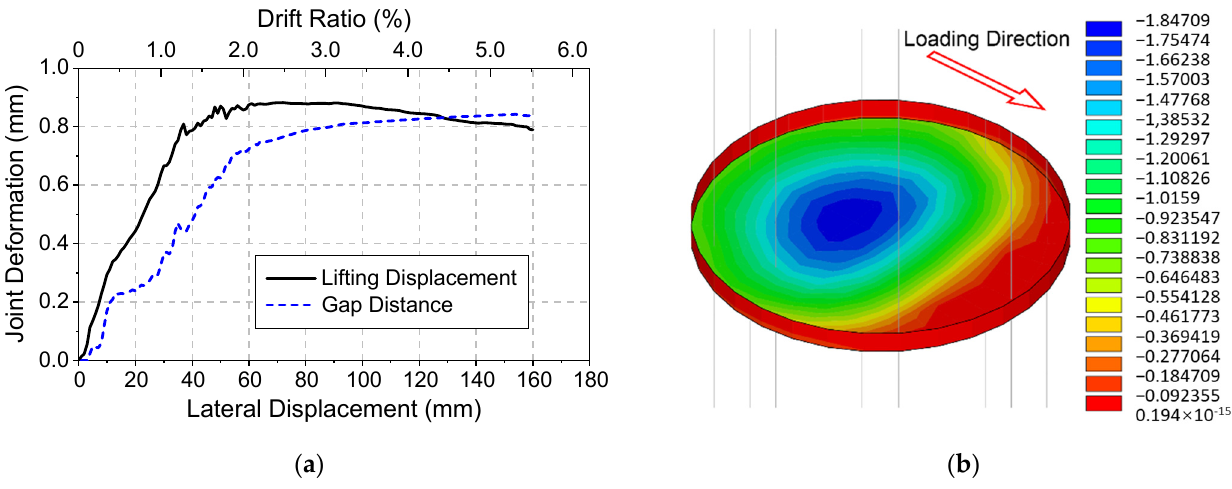
Figure 14. PMR’s ( a ) joint deformation curves; ( b ) gap distance at the displacement of 160 mm. (unit: mm).